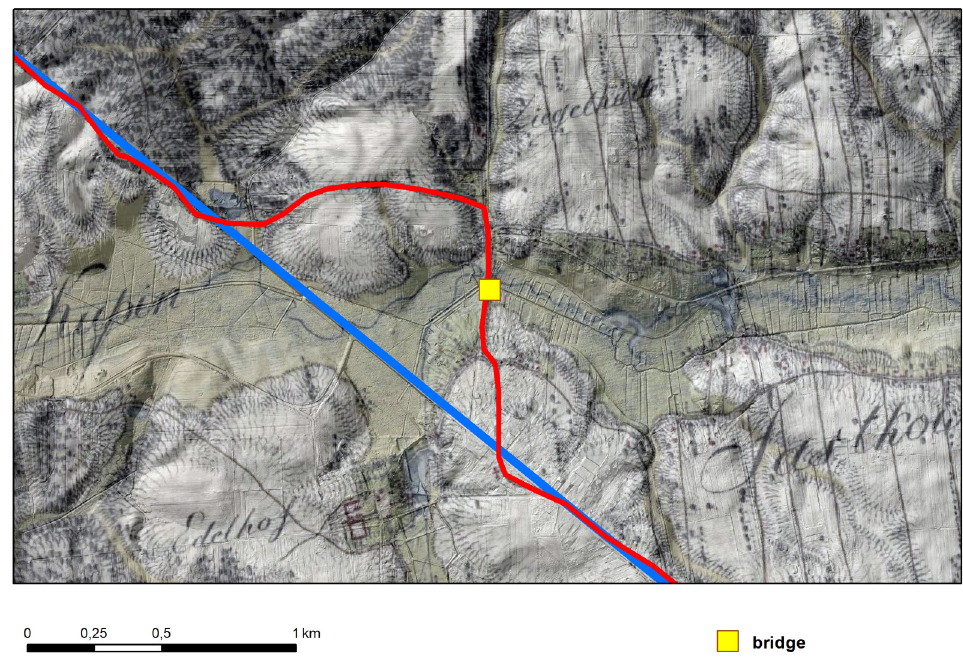
Fig. 1. The course of the road through the Ciemięga Valley west of Jastków in the second half of the 18th century – red line; in the first half of the 19th century – blue line (author’s own